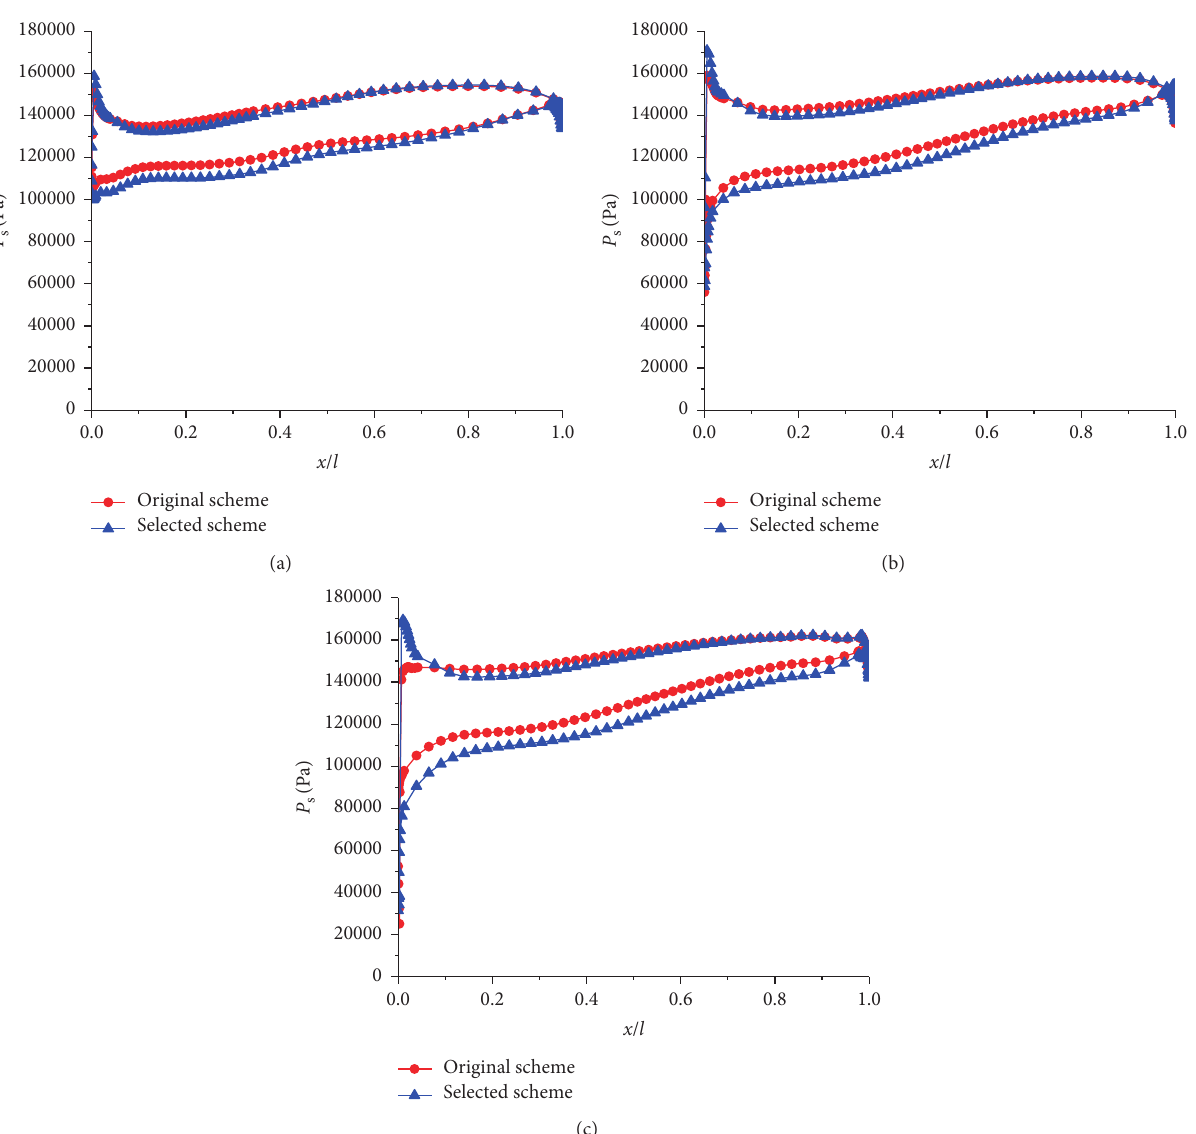
Figure 15: Static pressure distribution on each span under 0.67 Q ′ condition: (a) span � 0.1; (b) span � 0.65; (c) span �